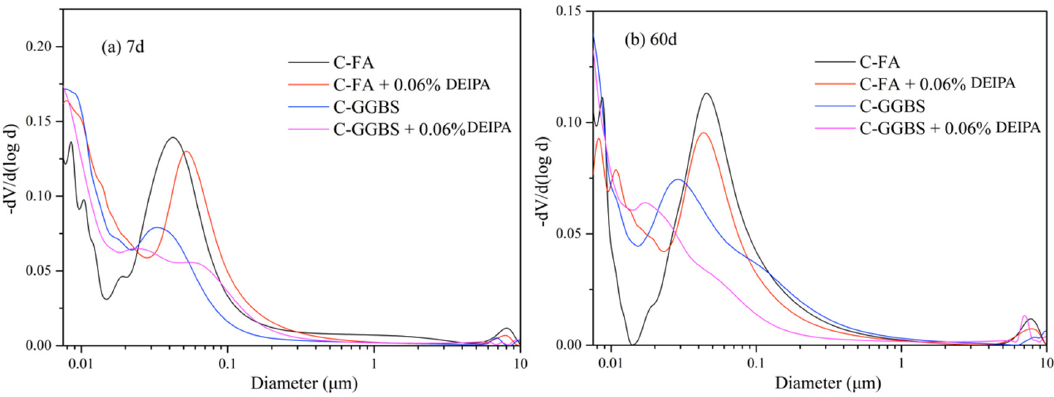
Figure 9. Pore distribution of C-FA and C-GGBS systems, ( a ) 7 d, ( b ) 60 d.